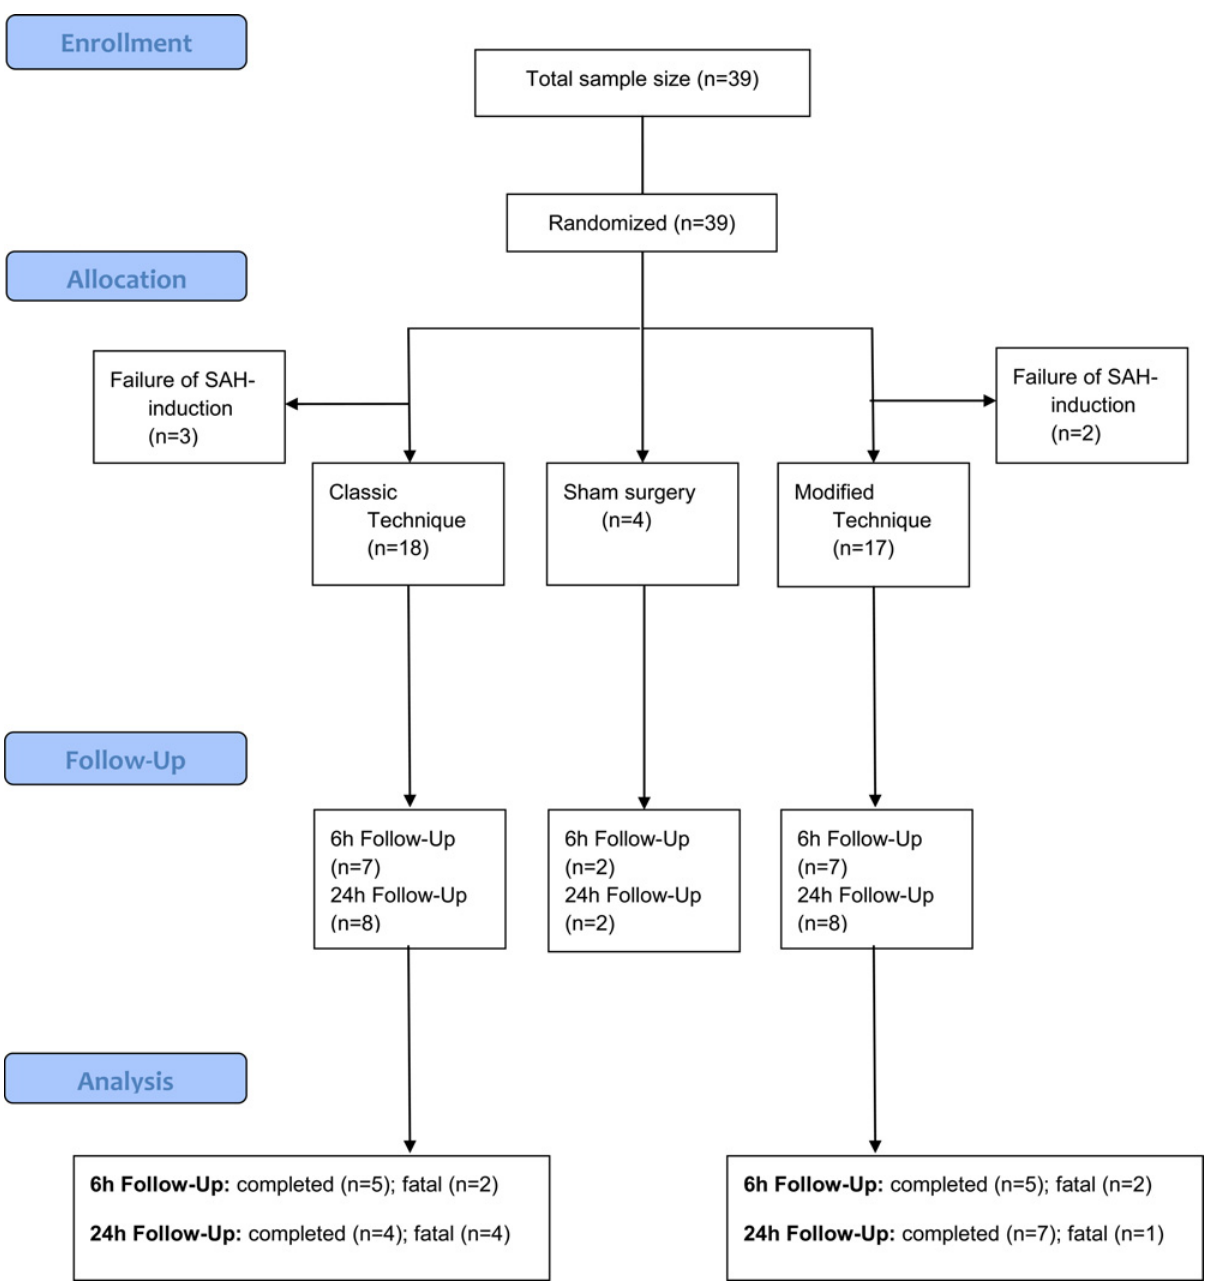
Fig 1. Diagram of animals enrolled. Diagram of animals enrolled: total sample size n = 39, invalid rCBF-data in n = 3 (6 h modified technique n = 1; 24 h modified technique n =